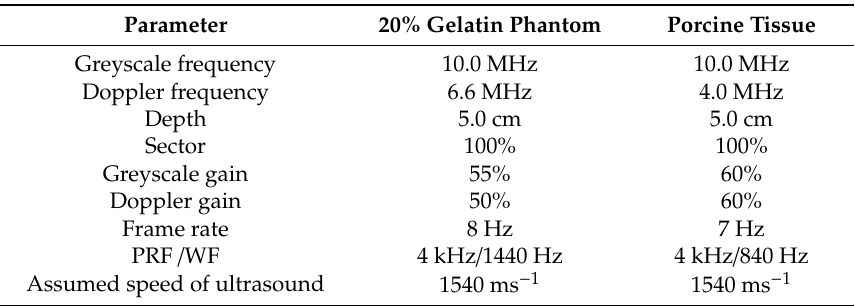
Table 1. Parameter settings of the SonixTouch ultrasound